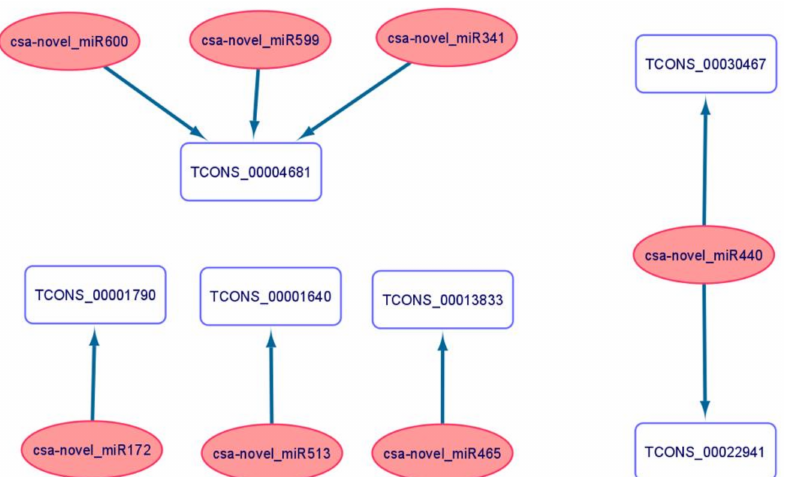
Figure 12. Interaction network analysis representing miRNAs (pink circles) with target lncRNAs (blue round